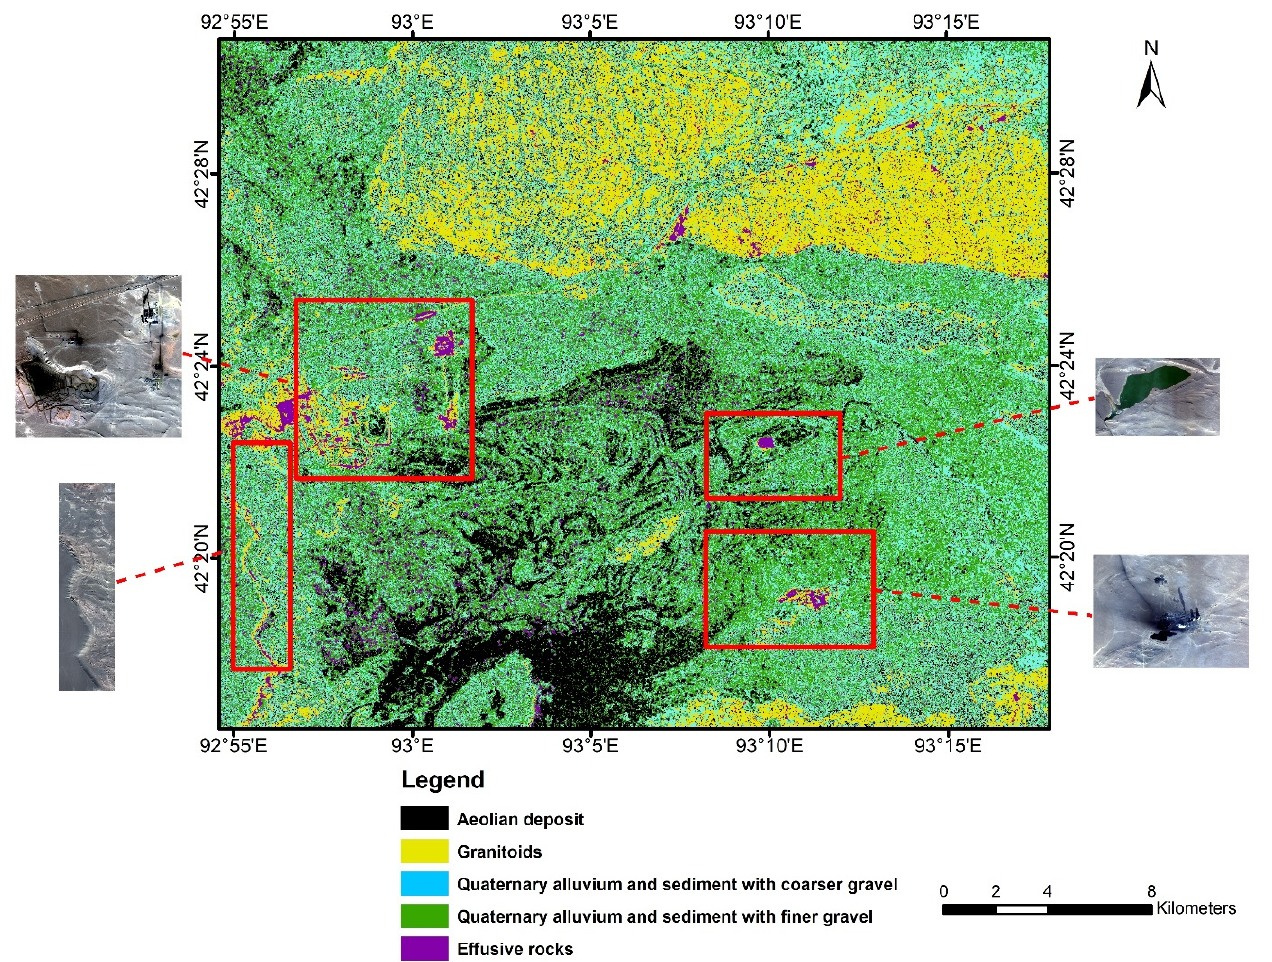
Figure 7. Results of lithological mapping using original parameters. The water body and landmark buildings in the figure are marked with WorldView-2 data© DigitalGlobe, Inc. (Westminster, CO, USA) (2020), provided by European Space Imaging.